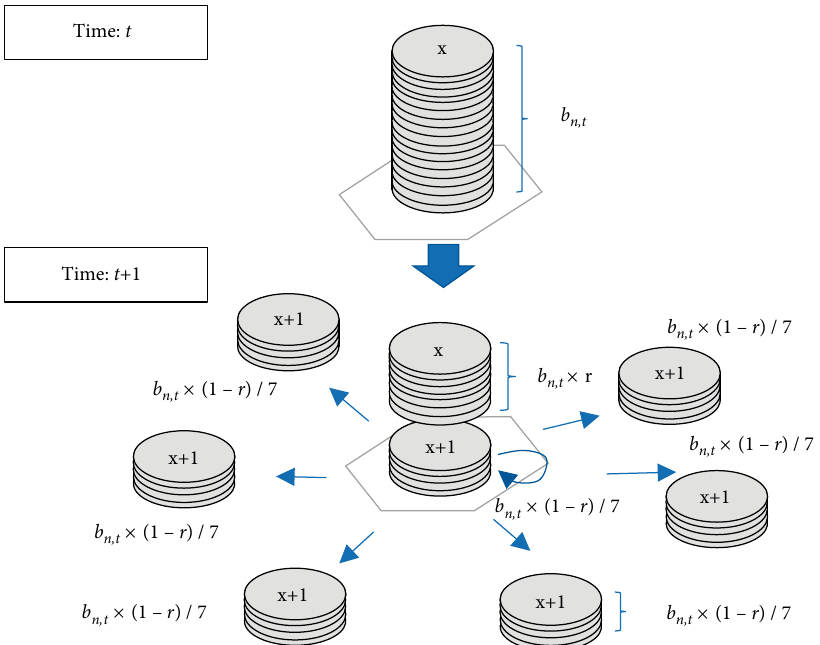
Figure 4: Schematic of token exchange. Each cell can contain multiple tokens concurrently. These are labeled with an integer value 𝑥 . Some tokens are moved to adjacent cells. The residual token ratio r is the fraction of unchanged (unmoved) tokens in each cell, where 𝑏 number of blocks in cell 𝑛 at time 𝑡 . (1) A proportion, 푏 × (1 − 푟) × 6/7, of the tokens evenly diffuse toward the six neighboring cells and 푛,푡 have their labels incremented by 1 upon arrival. (2) A proportion, 푏 × (1 − 푟) × 1/7, of the tokens remain in the original cell and have their 푛,푡 labels incremented by 1. (3) The residual, 푏 × 푟, tokens remain in the original cell without modification of their integer labels. If the number 푛,푡 of tokens is not an integer multiple of 7, the remainder of the tokens are distributed between the adjacent cells with equal